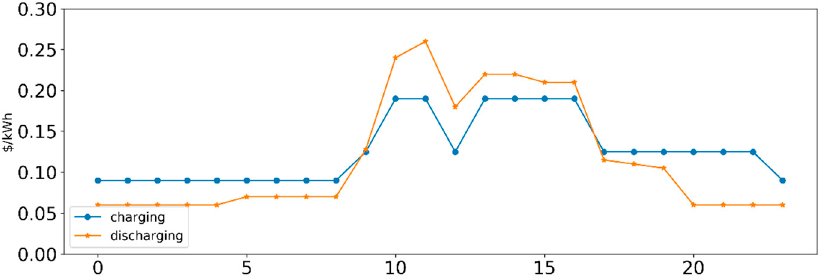
Figure 6. Electric vehicle charging and discharging tariff profiles during each day.